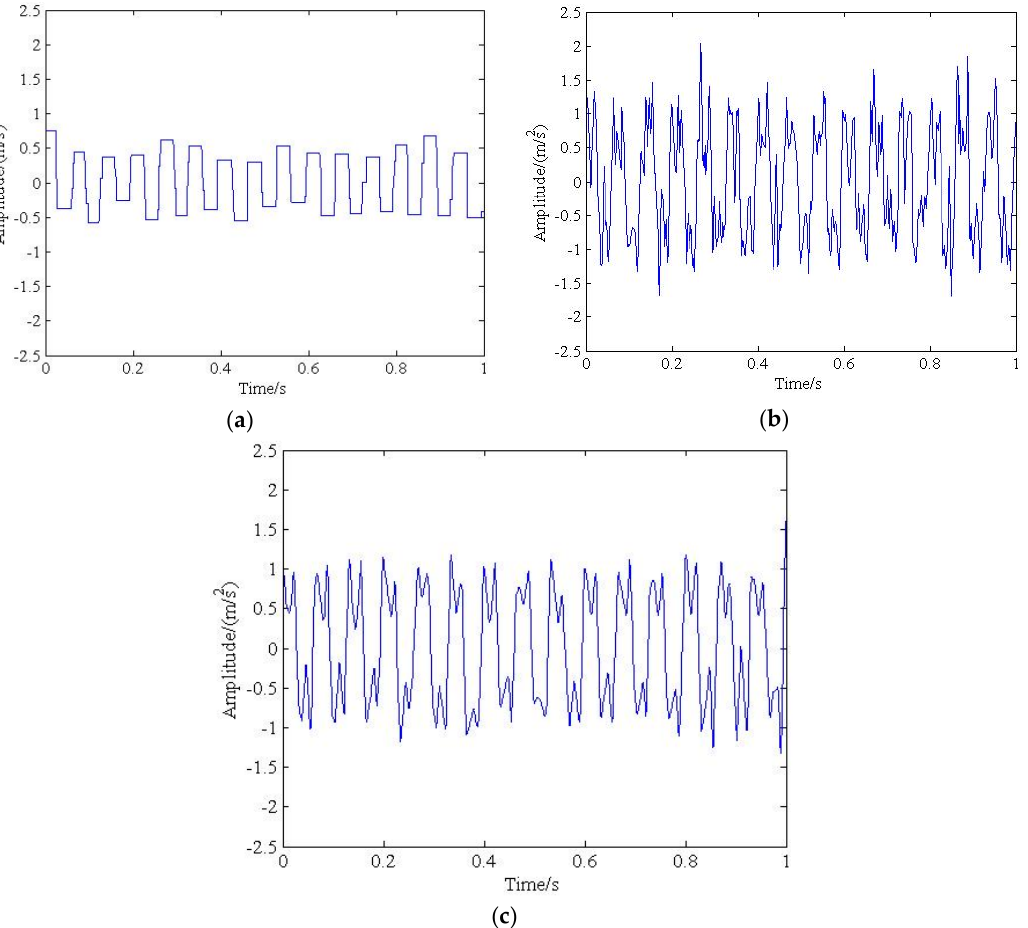
Figure 2. Comparison of the different denoising methods. ( a ) Simulation results of TV denoising; ( b ) Simulation results of wavelet transforms denoising; ( c ) The results provided by the proposed